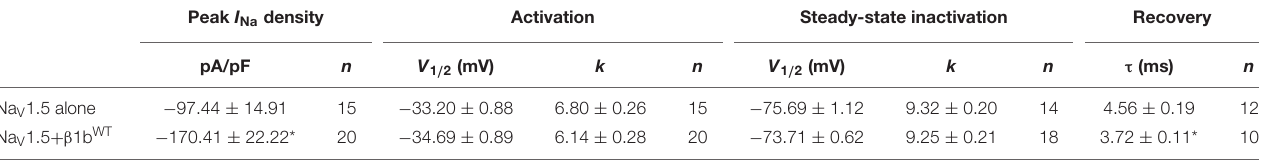
( Figure 3C left and Table 1 ). No changes were observed in voltage dependence of activation upon expression of Na V 1.5 + β 1b WT ( Figure 3C right and Table 2 ). Voltage dependence of inactivation was not altered by either β 1 WT or β 1b WT